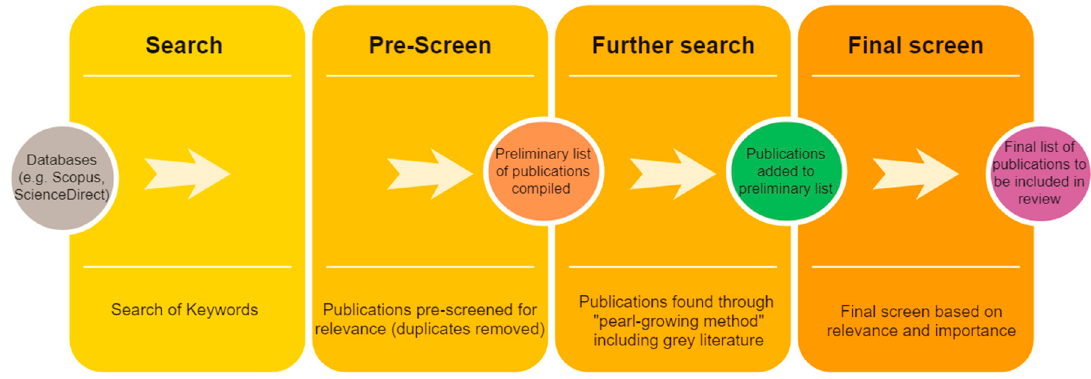
Figure 1. Diagram outlining review methodology used .